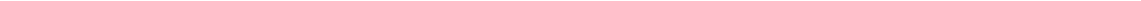
Fig. 4 Physical and functional properties of lost, gained, and conserved replication origins. The original dataset comprises 1073 conserved, 207 gained, and 187 lost origins; however, after fi ltering for dubious cases the number of total gain and loss is both 151 events. In all panels, *** and * represent P < 10 − 03 and P < 5×10 − 02 , respectively, using a chi-square two-sample test. a Distribution of the distance separating Conserved (C), Gain (G), and Lost (L) origins from their nearest origins. The pie charts show the expected, i.e. the theoretical percentages if the nearest origins were randomly sampled in the population of origins and the observed proportions of C, G, and L nearest origins for the three categories. b Distribution of the ef fi ciencies of C, G, and L origins and of their nearest origins. c Split distributions of the ef fi ciencies of C and G origins based on the category of their nearest origin. d Distribution of the fi ring ef fi ciencies as a function of the number of Lachancea species comprised into the families of orthologous origins ( R 2 = 0.891 on median values, P = 4.1×10 − 05 ). For boxplots in a – d , whiskers are de fi ned by selecting the values within the range of the 75th and 25th percentile plus or minus 1.5 x (75th percentile – 25th percentile) respectively, and at the maximum distance from the median. e Correlation between origin ef fi ciency and origin age for 546 origin families comprising 220 ancestral and 326 Lachancea- speci fi c families ( R 2 = 0.44, P = 1.3×10 − 03 ). Each dot represents the median ef fi ciency of all the replication origins that appeared in a given branch of the phylogenetic tree. The x -axis represents the total branch length between L . A2 (the last common ancestor of the nine species, indicated in light gray) and the branch of appearance of the new origins, placing the most ancestral origins on the left and the youngest on the right of the plot. Vertical error bars represent the standard deviation of origin ef fi ciencies and horizontal bars represent the span of the branch lengths based on the phylogenetic tree in Fig.